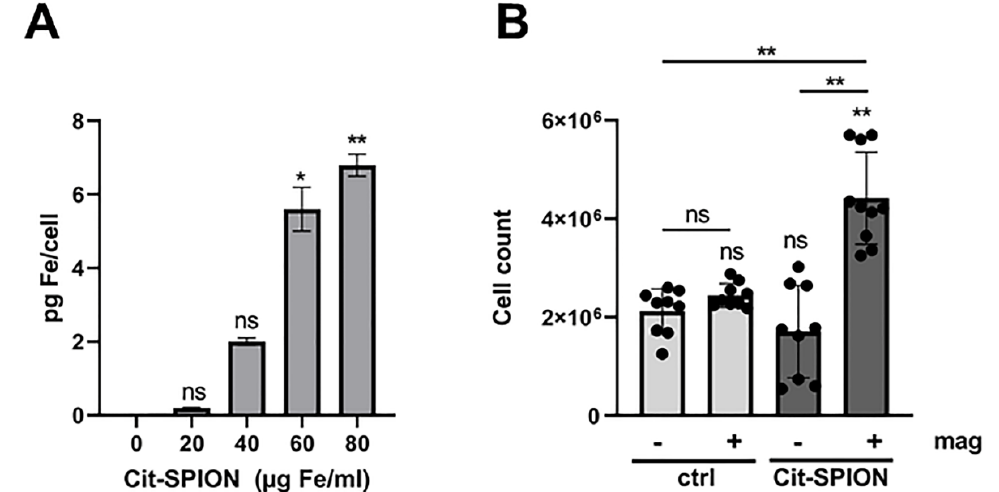
Figure 5. Enrichment of SPION-loaded Jurkat cells in a dynamic pump system. ( A ) Jurkat cells were loaded with Cit-SPIONs overnight. Cellular iron content was measured with AES. ( B ) Cit-SPION- loaded as well as non-loaded Jurkat cells circulated in the dynamic system for 1 h, in the presence or absence of magnets around the chamber. After 1 h, the cell count was determined in the chamber. The experiment was performed once ( A ) or three times in triplicate ( B ). The mean values with standard deviations are shown. Significances were calculated using nonparametric Kruskal-Wallis ( A ) or one-way ANOVA ( B ) with * p ≤ 0.05, ** p ≤ 0.01, ns =